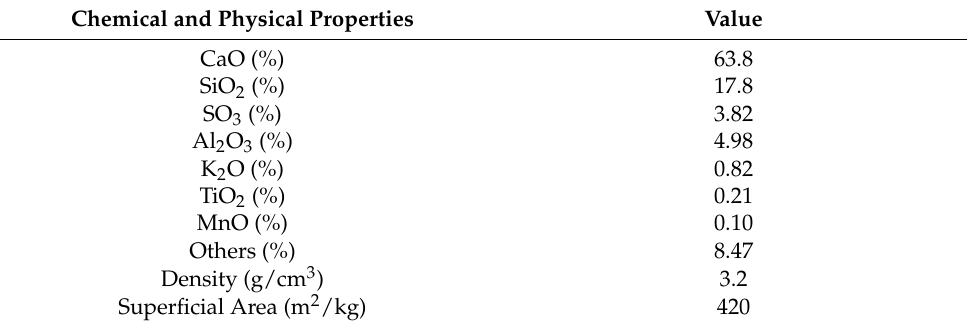
Table 2. Chemical composition of type CPV-ARI cement.